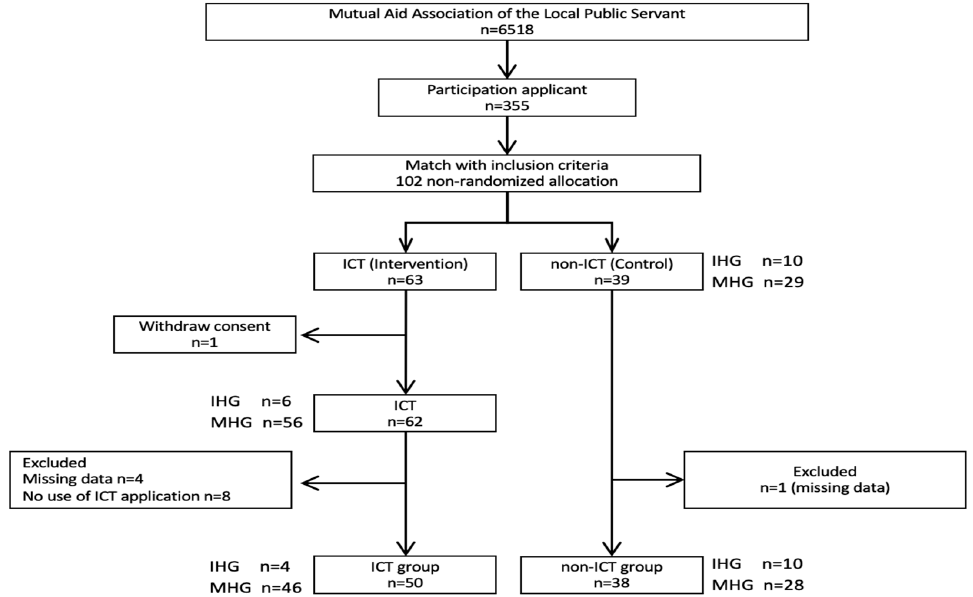
Figure 1. Enrolment of study participants. Note: ICT: information and communication technology; IHG: Intensive Health Guidance; MHG: Motivational Health Guidance.